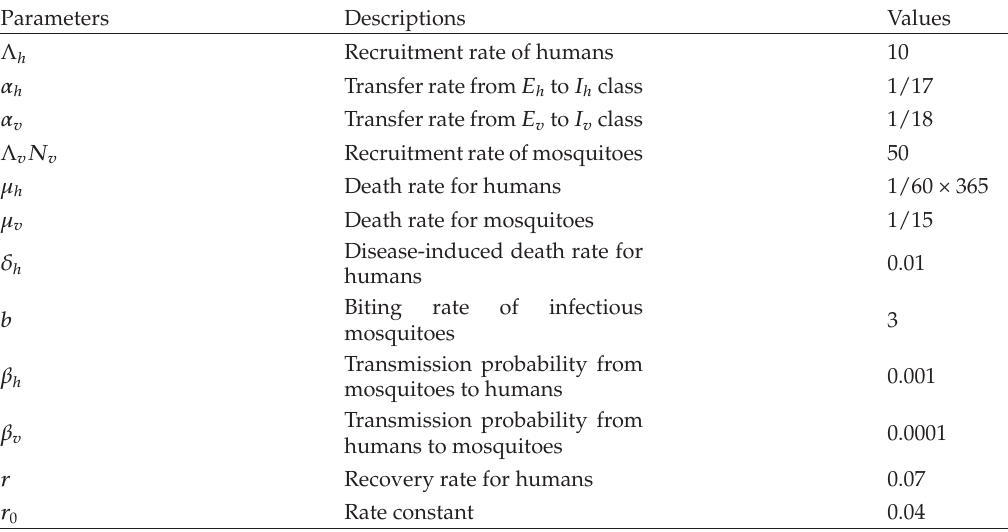
Table 1: Parameters, their symbols and values used in